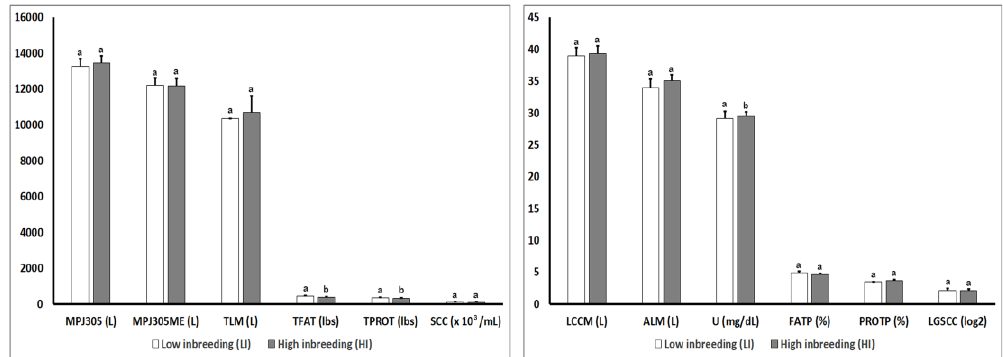
Figure 3. Effect of the degree of inbreeding (LI versus HI) on phenotypic parameters for production traits in high-producing primiparous dairy cows. Production phenotypic values: MPJ305: Projected Milk at 305 days; MPJ305ME: Projected Milk 305 days Maturity Equivalent; TLM: Total Liters of Milk; TFAT: Total Fat; TPROT: Total Protein; SCC: Somatic Cell Count; LCCM: Liters of Current Corrected Milk; ALM: Average Liters of Milk; U: Urea; FATP: Percentage of Fat; PROTP: Percentage of Protein; LGSCC: Logarithmic Somatic Cell Count. Different letters show statistical differences between values ( p ≤ 0.05). L: Liters; lbs: Pounds; %: Percentage; mg: milligrams; dL: deciliters; SEM: Standard Error of the Mean.